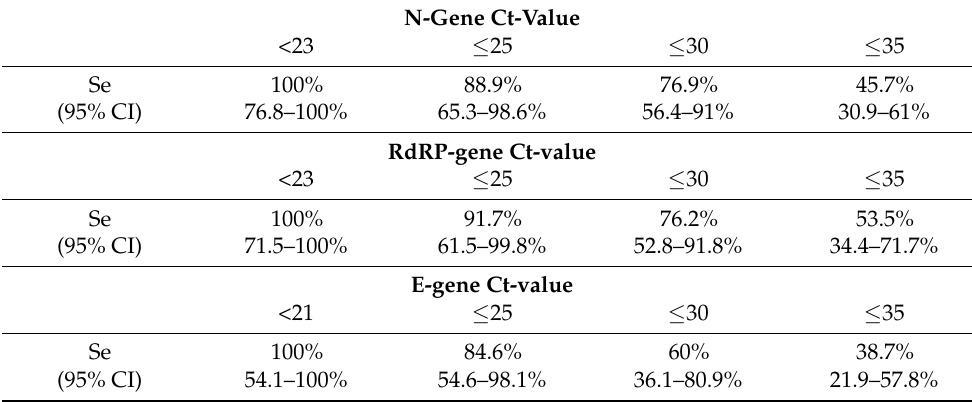
Table A4. Overall sensitivity of the RAT according to the different